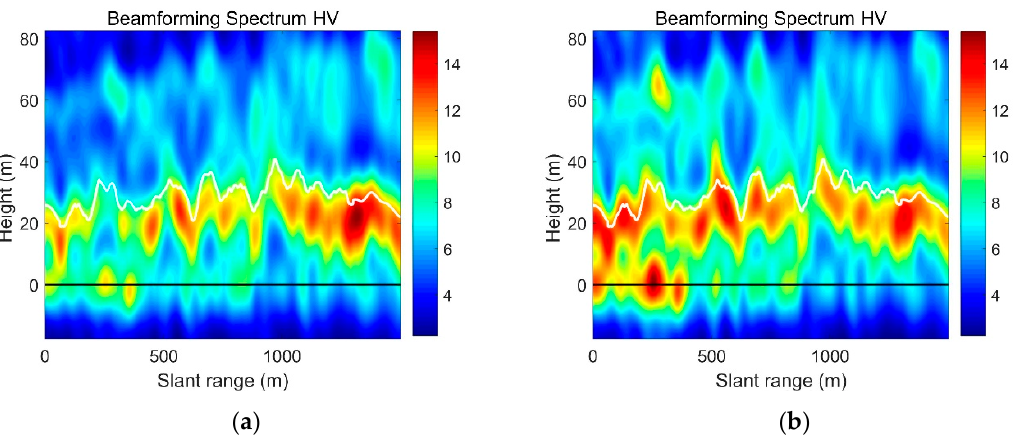
Figure 9. TomoSAR forest vertical structure profile. ( a ) Before terrain compensation; ( b ) after terrain compensation.